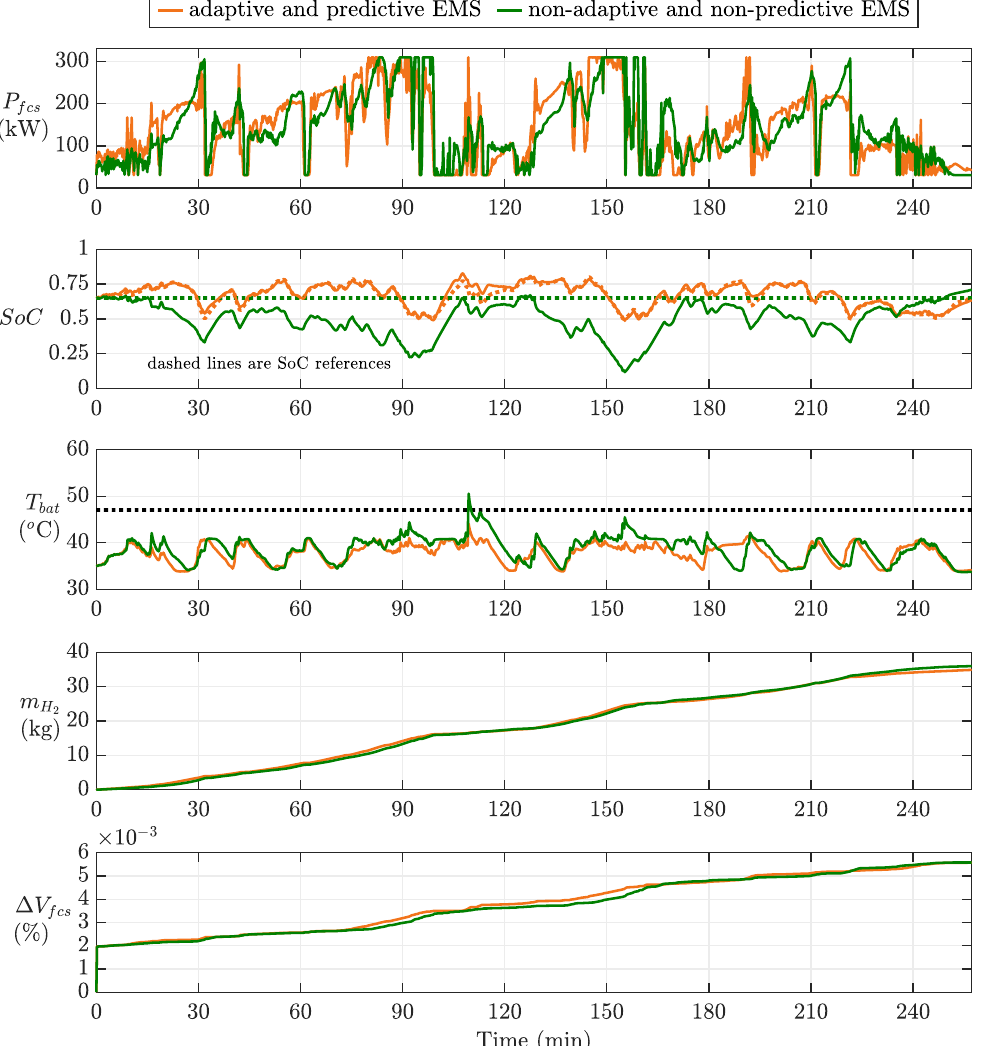
Figure 12. Simulation results comparison between predictive and non-predictive EMSs at ambient temperature of 20 ◦ C.